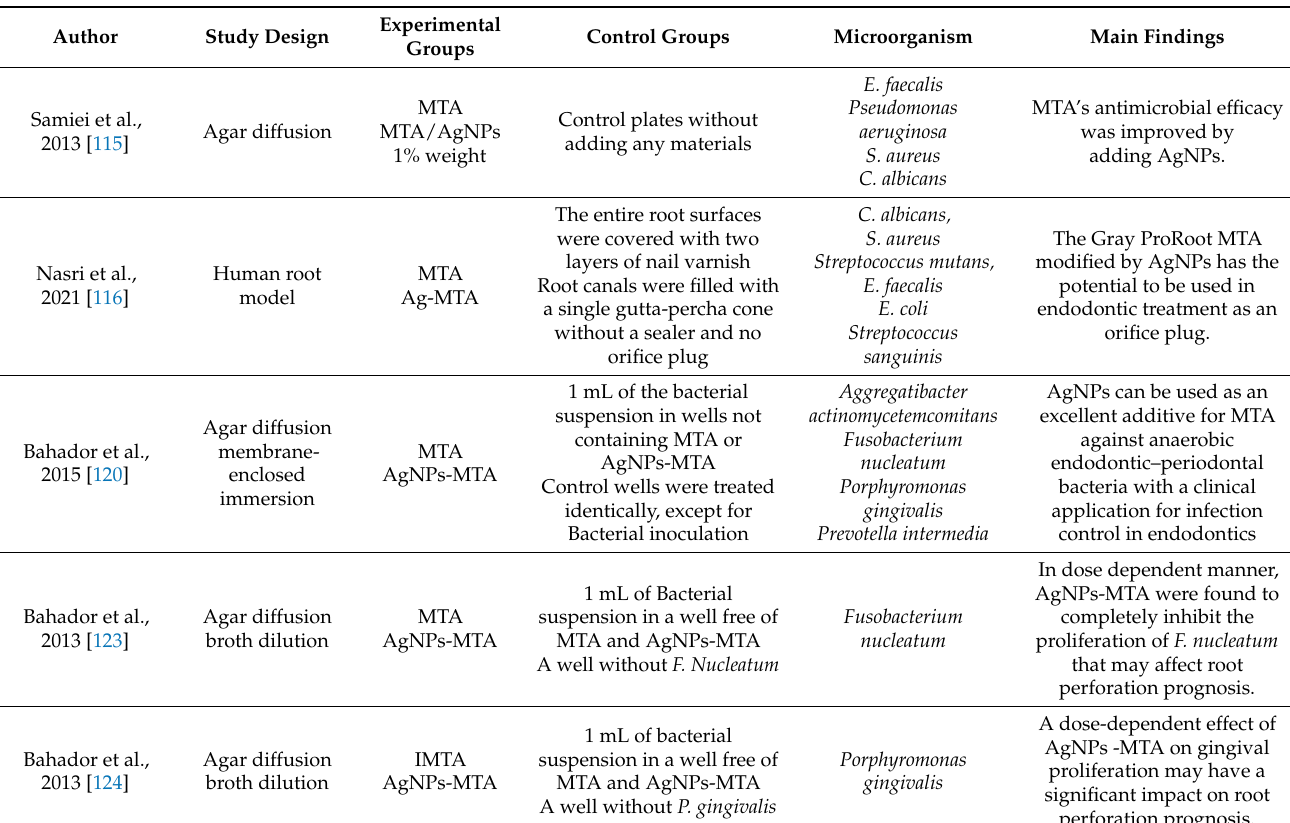
Table 5. Studies of alternative MTA highlighting study design, experimental and control groups, microorganisms tested, and main